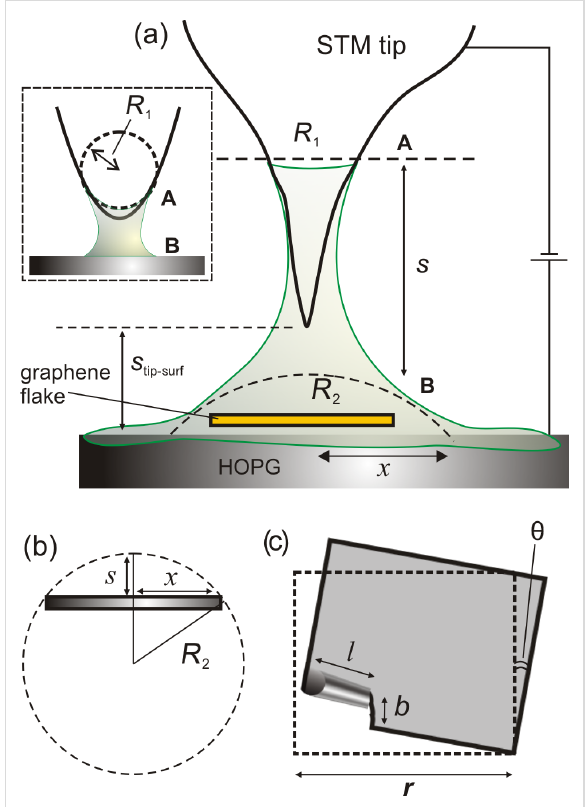
Figure 3: (inset) Sphere–plane geometry with an atomically sized sphere of radius R 1 at the tip side (A-side), (a) proposed model suit- able for STM solid–liquid interface with the meniscus possessing a radius of curvature R 2 at the surface (B-side) where R 2 << R 1 , (b) sketch for calculating the radius R 2 in terms of the spread ( x ) of the liquid on the surface, (c) schematic of the graphene flake that has undergone rotation, tearing and partial